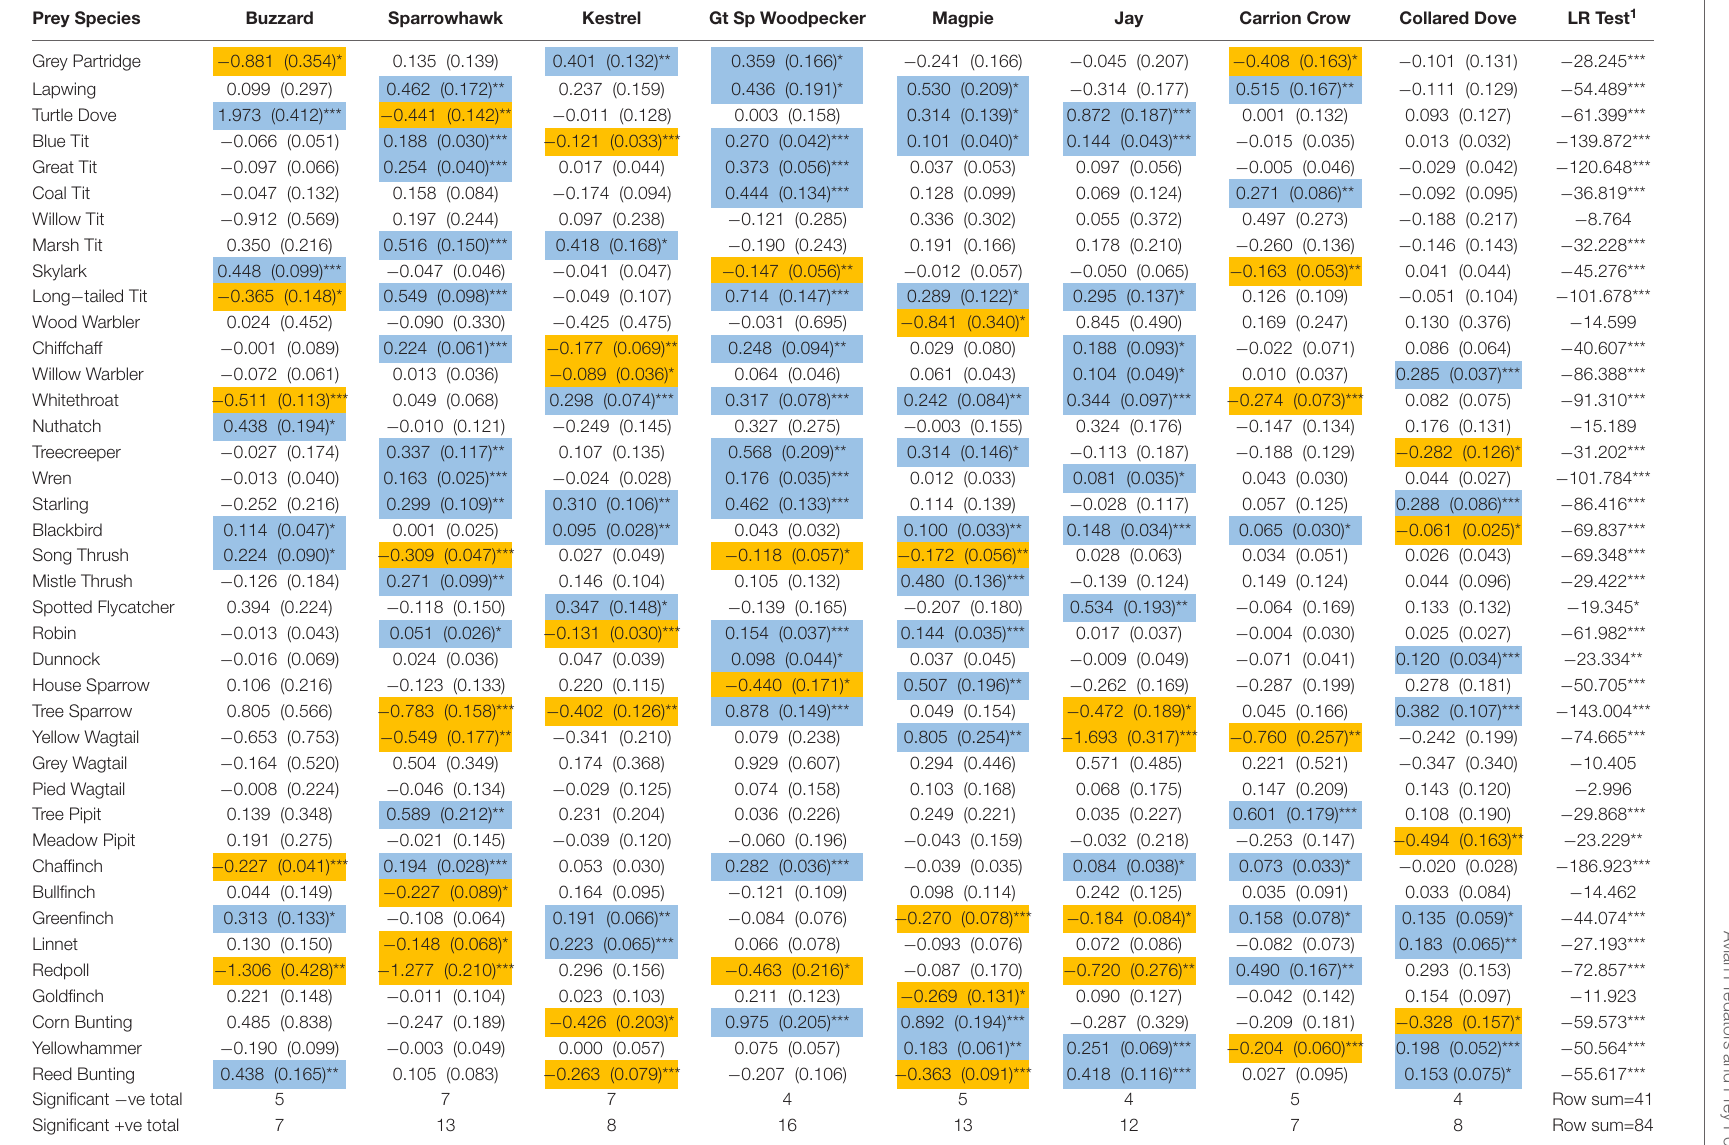
TABLE 1 | Estimated effects with standard errors in brackets from multiple regressions of change in prey abundance against change in predator